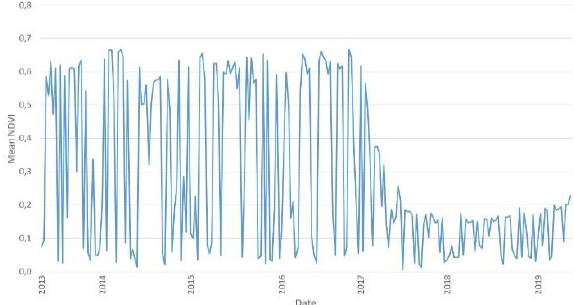
Figure 11. Landsat 8 NDVI time series of the affected forest area generated by using